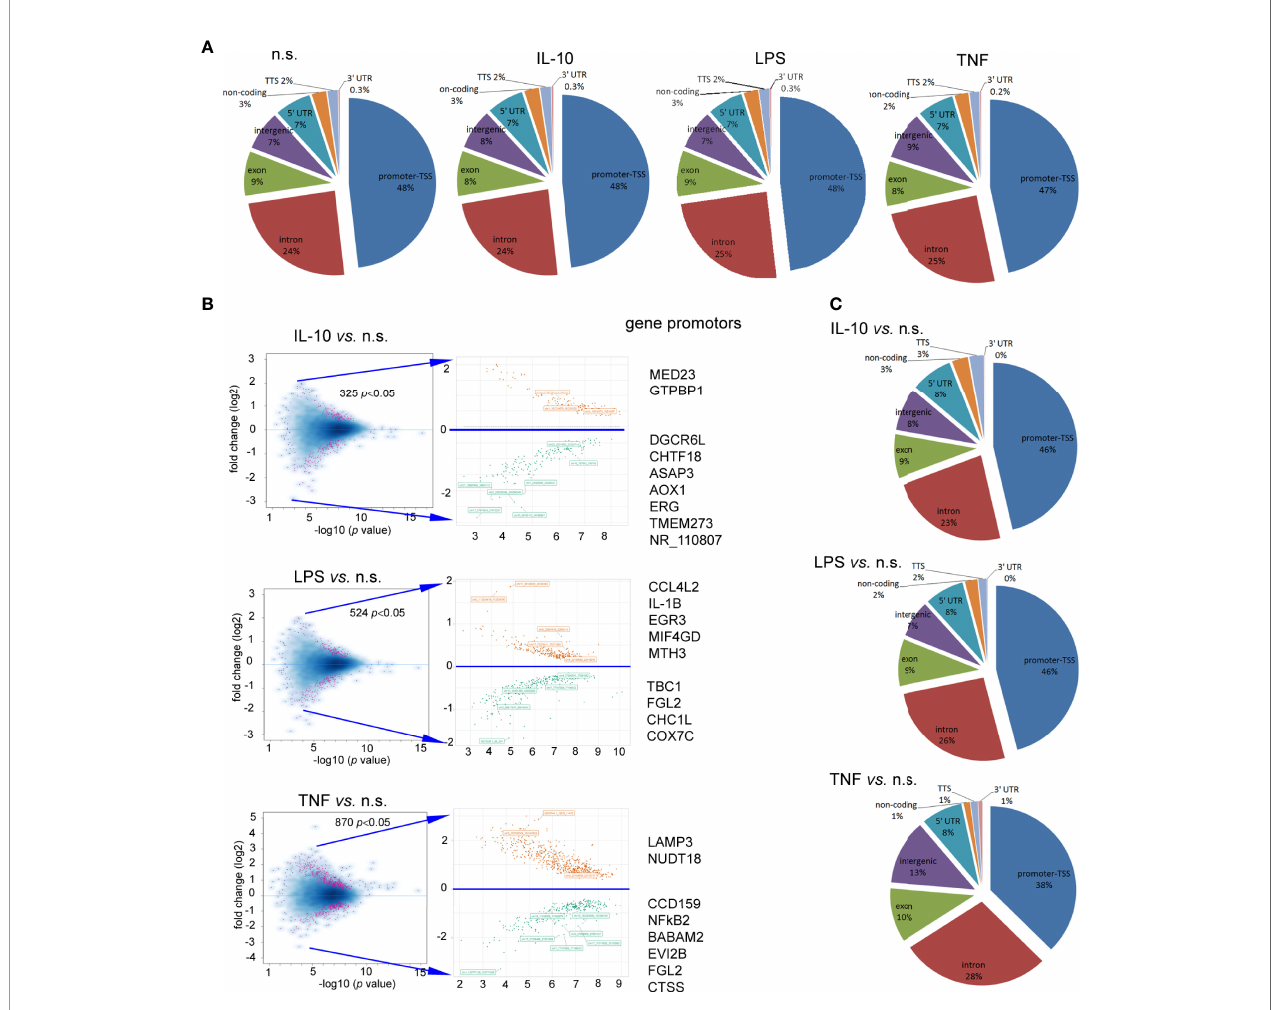
FIGURE 3 | Neutrophils stimulated by IL-10, TNF- a , or LPS equally impacts each DNA annotation, indicating the involvement of various DNA components within H3K4me3-marked histone. (A) Distribution of the DNA annotation in H3K4me3-marked histone after stimulation by IL-10, LPS, or TNF- a . (B) Volcano plots demonstrated statistical signi fi cance in peak density compared to n.s. neutrophils from four independent biological replications. (C) Distribution of the DNA annotation within statically signi fi cant peaks associated with H3K4me3 revealed the most signi fi cant changes observed in the TSS region during the exposition of neutrophils to IL-10 or LPS. Each graph was performed based on the mean value calculated from four independent experiments; n.s,